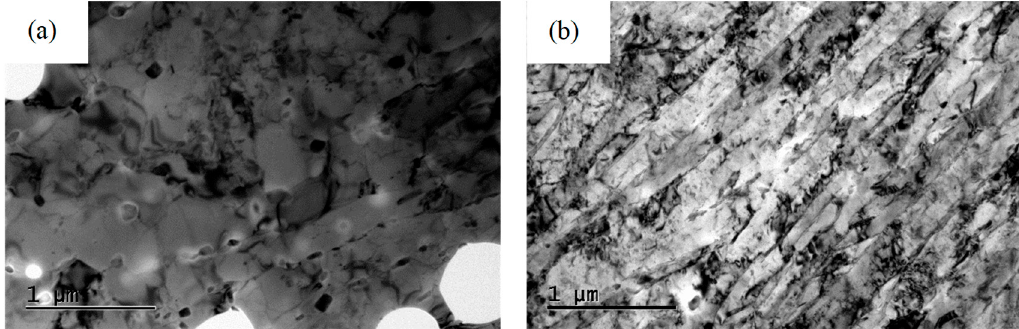
Figure 12. Microstructure comparison of two materials after stretching at 700 °C. ( a ) Alloy 1; ( b ) alloy 2.